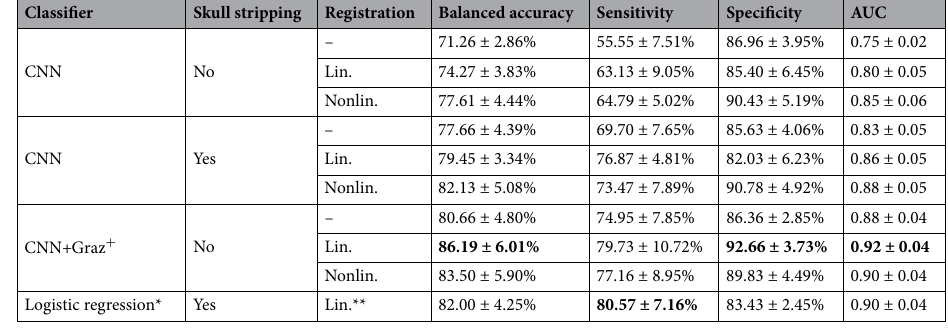
Table 1. Mean performance (in %) for the different models on all holdout data sets of cross validation. Highest values per column are highlighted in bold. AUC area under the curve of the receiver operating characteristics. *Logistic regression by FSL-SIENAX. **Linear registration is applied during FSL-SIENAX processing to obtain scaling